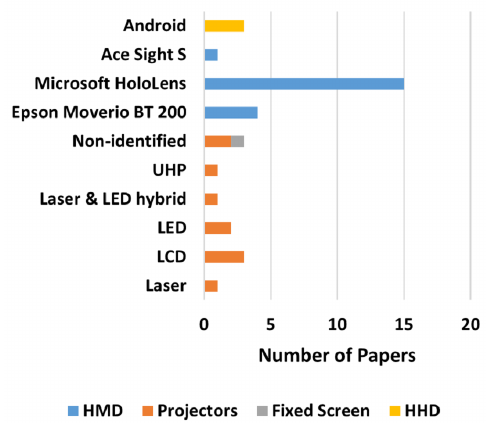
Figure 20. Equipment by visualization